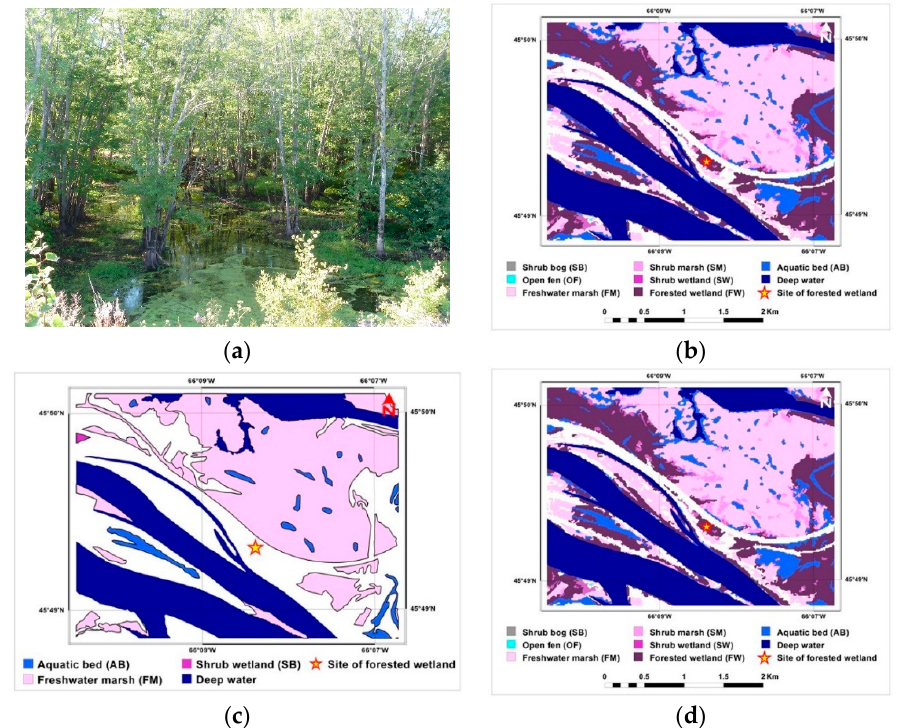
Figure 5. Comparison between the classified image, the 2016 NB reference map, and the 2019 NB reference map for a forested wetland site. The ground picture of the site is also given. ( a ) Ground picture; ( b ) Classified image; ( c ) 2016 NB reference map; ( d ) 2019 NB reference map.